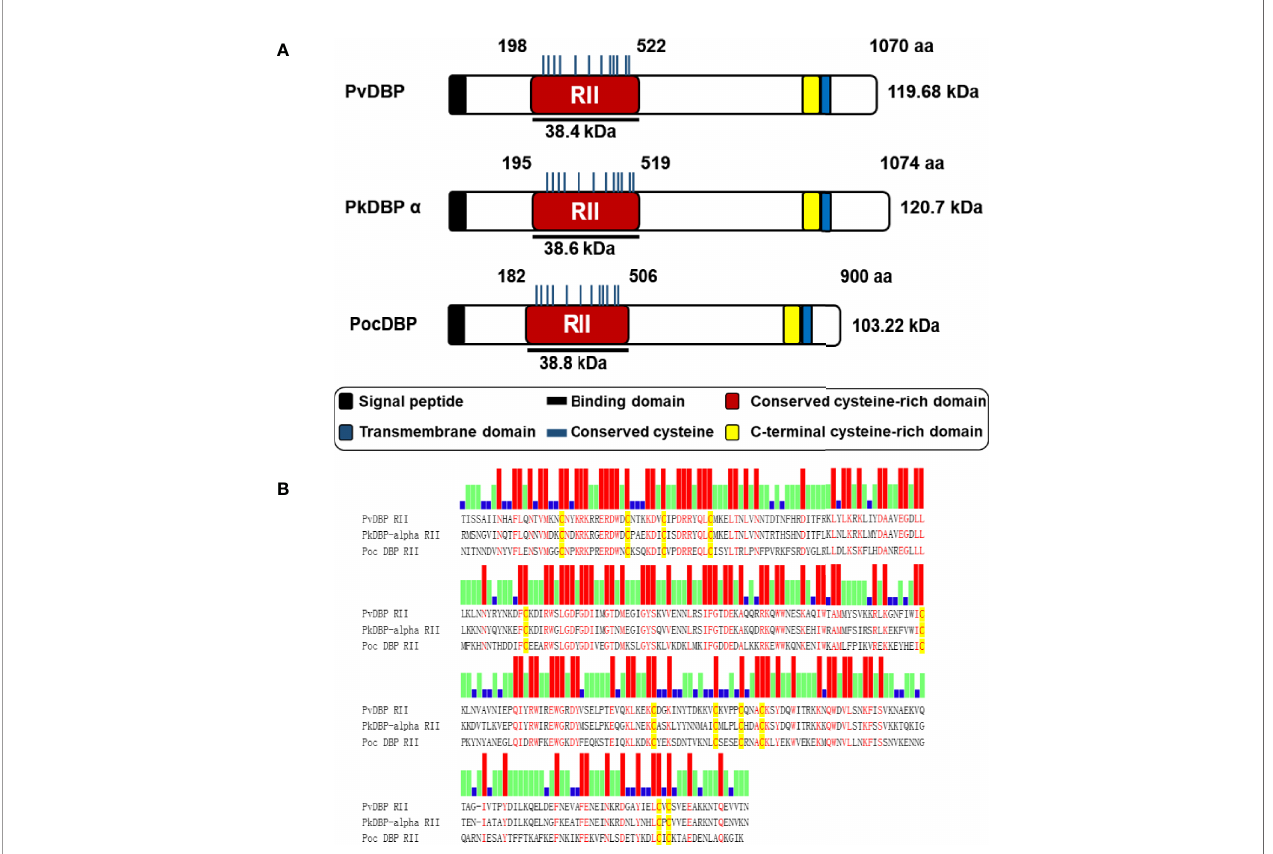
FIGURE 1 | Schematic depiction and sequence alignments of DBP proteins. (A) Schematic depiction of PvDBP, PkDBP- a and PocDBP. The PocDBP-RII (aa 182 – 506) domain was expressed using bacterial expression systems. The signal peptide (black box), transmembrane domain (blue box), recombinant protein expression (black bar) and functional erythrocyte-binding domain (red bar) are indicated. (B) Clustal alignment of the PvDBP-RII, PkDBP- a -RII, and PocDBP-RII homologous sequences. The red bar represents the conserved identical amino acids in the alignment of the three proteins, the green bar represents identical amino acids in two proteins, and the blue bar represents diverse amino acids in the three proteins. The yellow shading denotes conserved cysteine